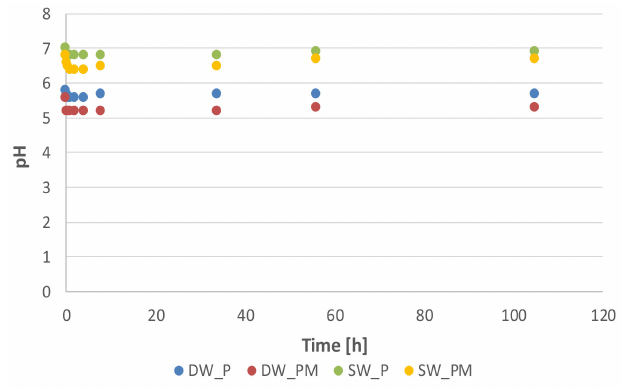
Figure 2. Changes in the pH of the tested systems during the adsorption process. DW_P—deionized water enriched with phosphate, SW_P—e ffl uent from a sludge enriched with phosphate. DW_PM—deionized water enriched with phosphate and metal ions, SW_PM—e ffl uent from a sludge enriched with phosphate and metal ions.